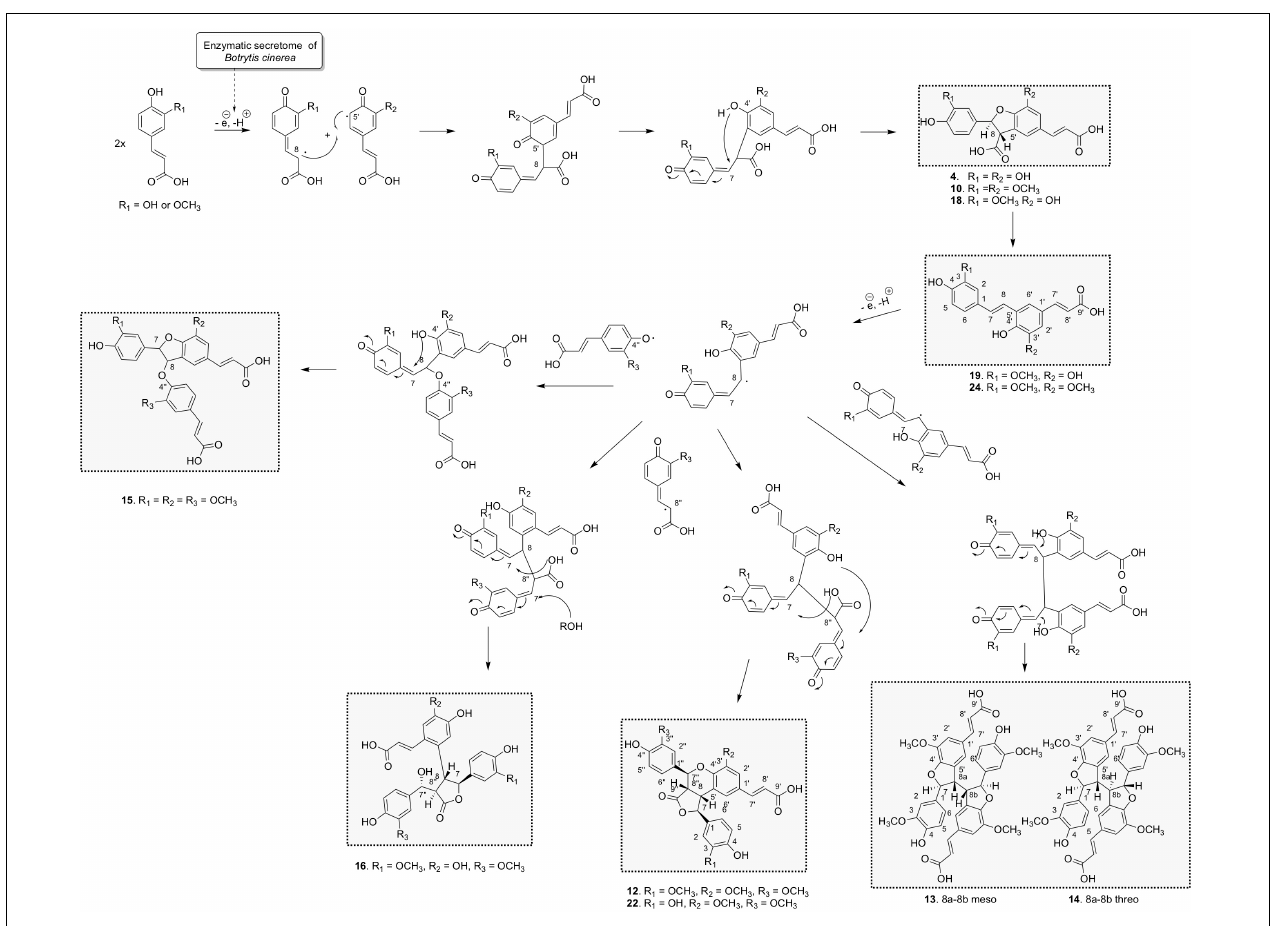
FIGURE 5 | Proposed chemoenzymatic pathway for the formation of compounds 4, 10, 12-16, 18, 19, 22, and 24 by 8-5 (cid:48) phenoxy radical coupling.